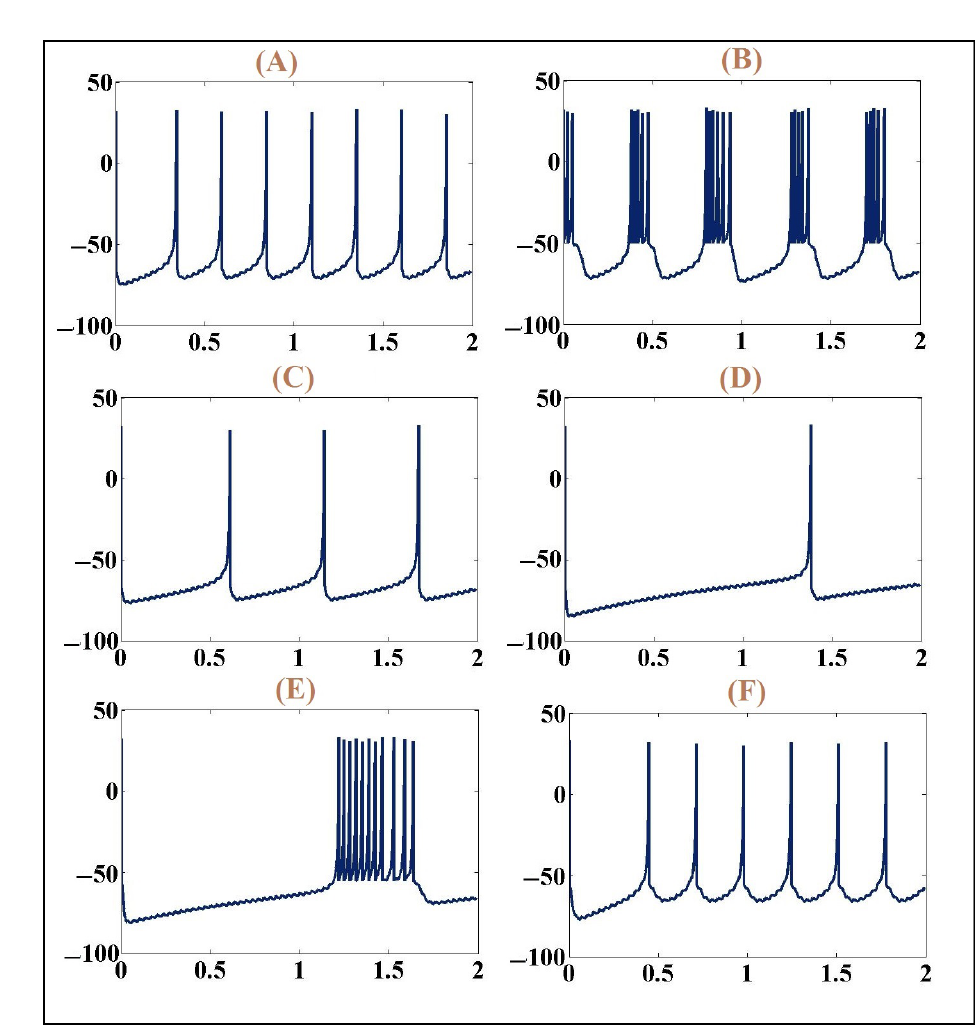
Figure 1. Spiking patterns of the Izhikevich neuron model. ( A ) Tonic spiking. ( B ) Tonic bursting. ( C ) Spike frequency adaption. ( D ) Phasic spiking. ( E ) Phasic bursting. ( F ) Mixed